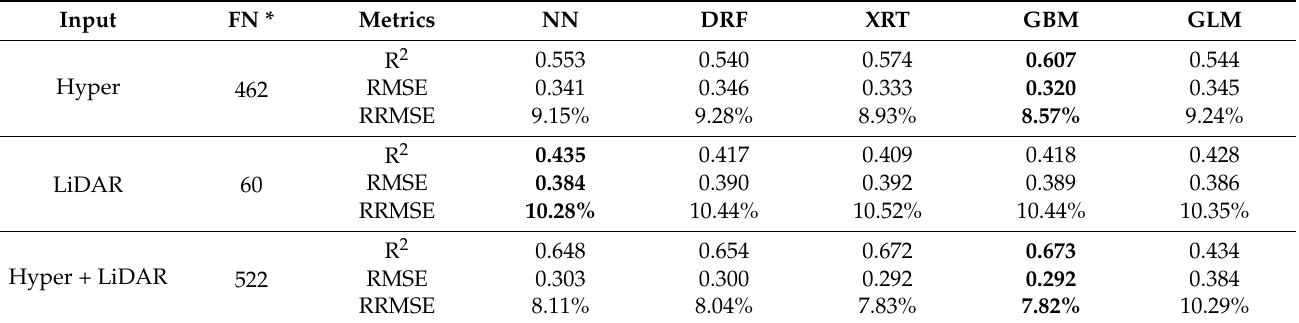
Table 9. Validation statistics of corn oil concentration estimation using five/different AutoML methods. Best prediction results are highlighted in